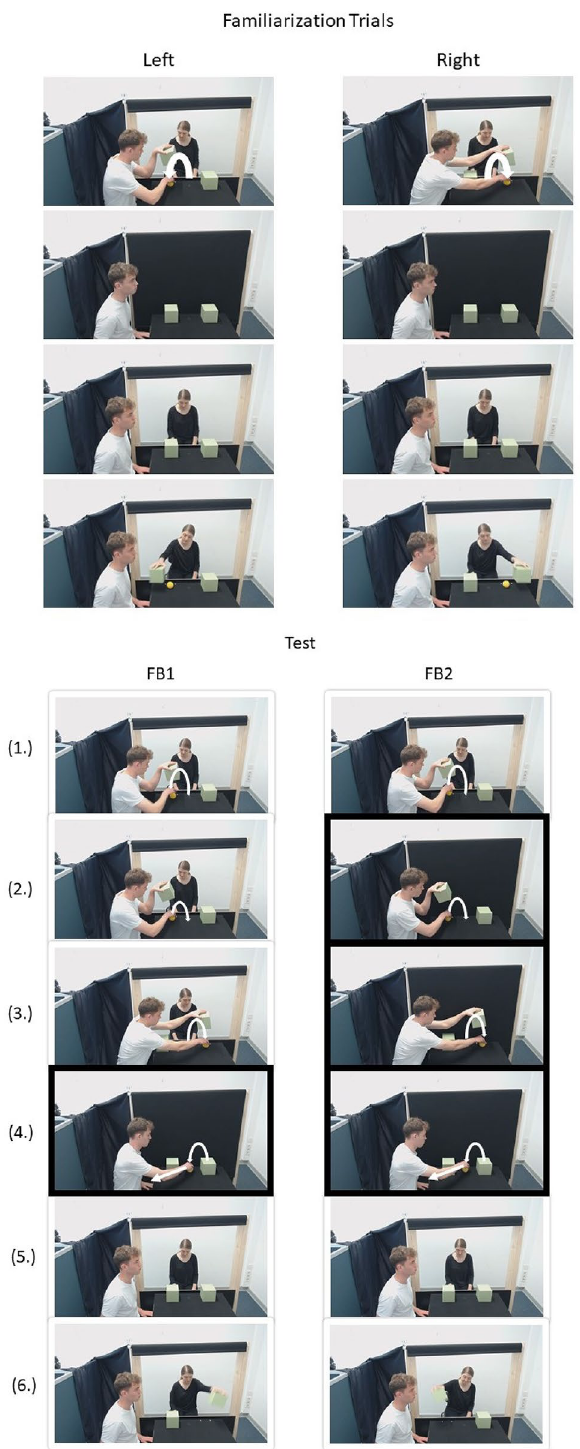
Figure 1. Order of behavior of the experimenter (left person) and the confederate (central person) during the familiarization and test trials. The FB1 and FB2 conditions differ regarding when the blind is closed (indicated by a black box around the images) or